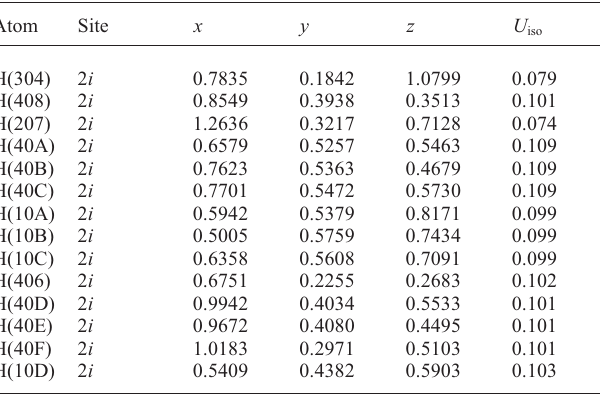
Table 3. Atomic coordinates and displacement parameters (in Å 2 )